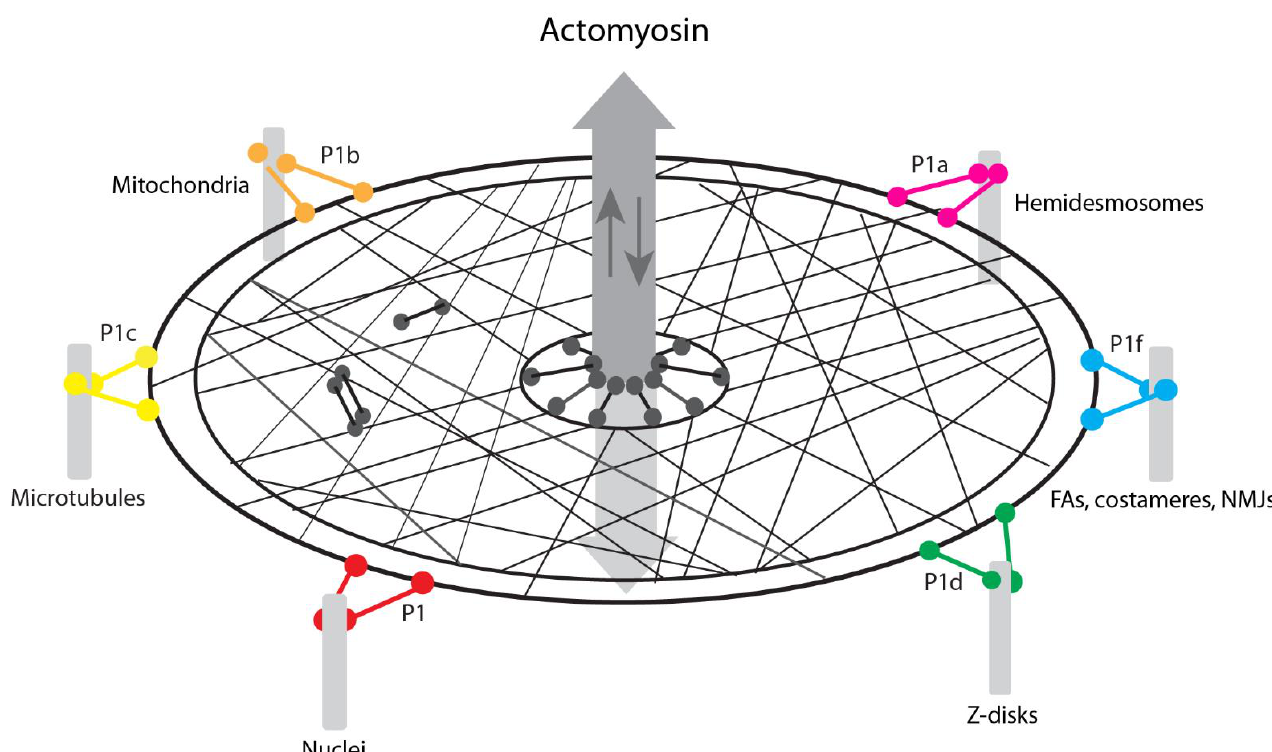
Figure 3. Model depicting plectin as a key element in the modulation of actomyosin forces through IF networks. The IF network is depicted as a safety net held up and spanned between posts via plectin sidearms. The posts represent the various organelles and cytoskeletal junctional sites that, in cells, are linked to IFs via different (color-coded) plectin isoforms. Note: desmosomes and other intercellular junctions, which most likely also are linked to IF networks via plectin, are not shown, as the type of isoform involved has yet to be identified. The bidirectional arrow in the center of the net stands for the actomyosin machinery which is physically linked to the IF network via plectin sidearms that presumably can be formed by any type of isoform as long as it contains a functional ABD (black dumbbells); plectin-mediated IF networking (exemplified by a dimeric and a tetrameric molecule) is also probably isoform type-independent as well. For hypothetical IF networking modes of dimeric and tetrameric plectin molecules, see [6]. Note: the depicted plectin-mediated linkages combined with the viscoelastic properties of the IF network (safety net) provide a mechanistic explanation how IFs modulate and counteract actomyosin-generated forces.